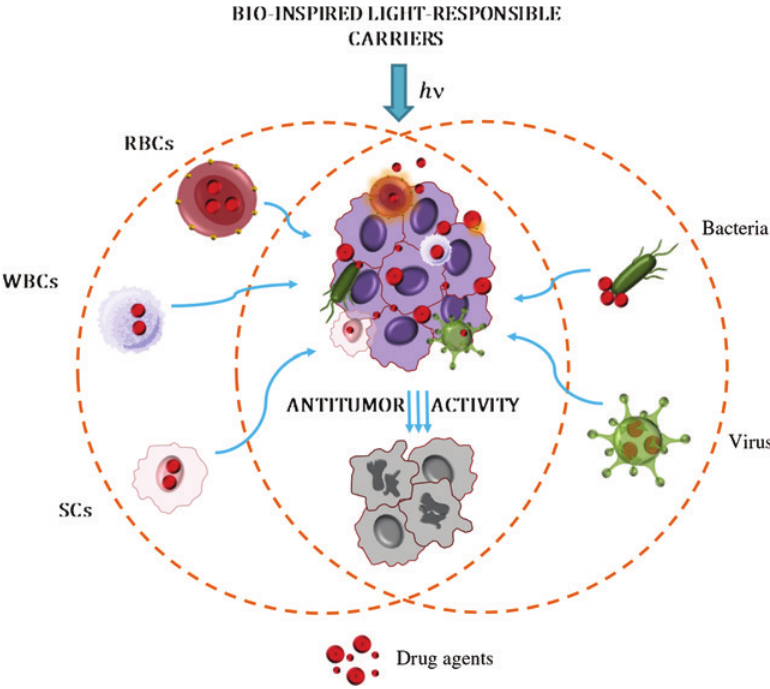
Figure 12: Schematic illustration of implementation of bioinspired light-sensitive